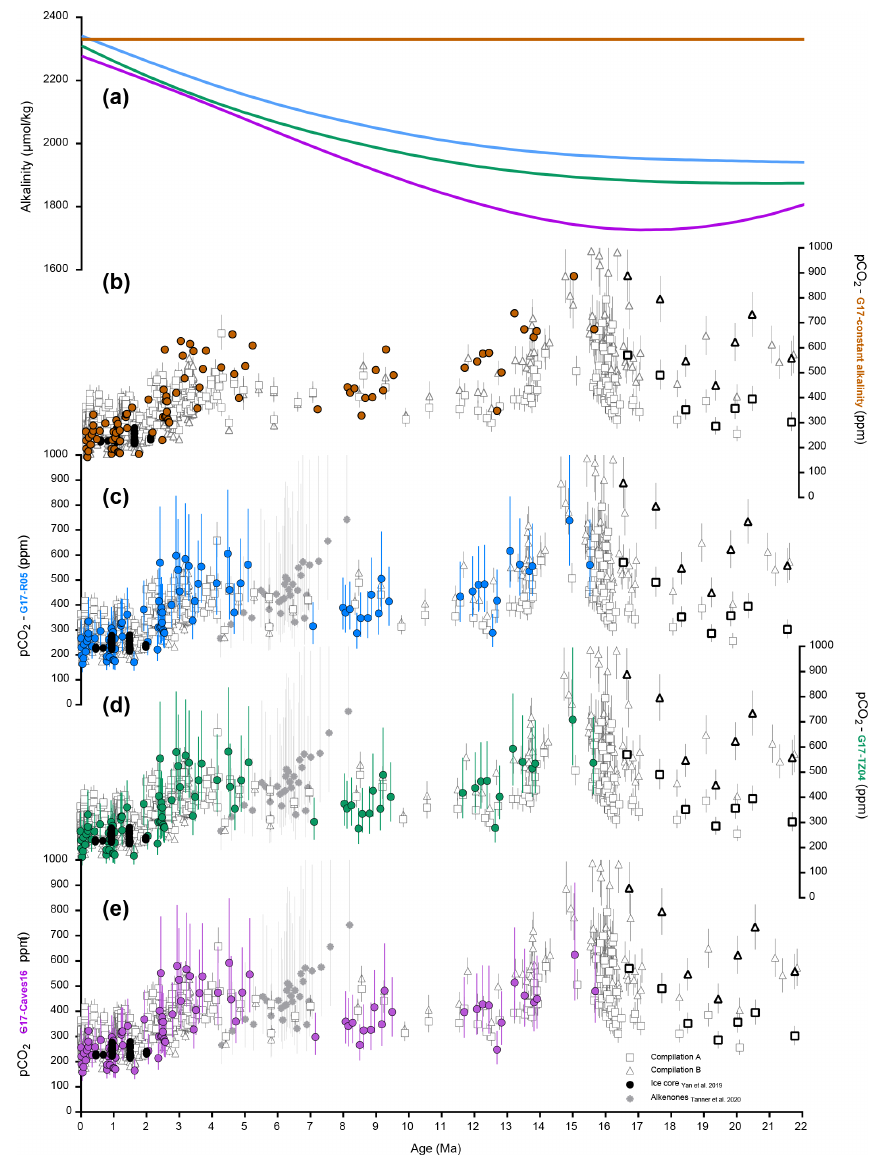
Figure 6. Different models for the evolution of a second carbonate (e.g., alkalinity) system parameter explored as part of this work. The propagated uncertainties were calculated using Eq. (S16) (see Supplement). (a) Different models for alkalinity used for the reconstruction of p CO 2 in this study (brown – constant alkalinity of 2330µmol/kg, blue – Ridgwell and Zeebe, 2005; green – Tyrrell and Zeebe, 2004; violet – Caves et al., 2016). Colored symbols are reconstructed p CO 2 based on our measured δ 11 B carbonate values, alkalinity scenario and δ 11 B seawater from Greenop et al. (2017); open squares (compilation A) are the p CO 2 compilation from Sosdian et al. (2018), open triangles (compilation B) are from the compilation by Rae et al. (2021), black symbols are from site 872. (b) Reconstructed p CO 2 using constant alkalinity of 2330µmol/kg and δ 11 B seawater from Greenop et al. (2017). (c) Reconstructed p CO 2 using the constant alkalinity scenario from Ridgwell and Zeebe (2005) and δ 11 B seawater from Greenop et al. (2017). (d) Reconstructed p CO 2 using constant alkalinity scenario from Tyrrell and Zeebe (2004) and δ 11 B seawater from Greenop et al. (2017). (e) Reconstructed p CO 2 using constant alkalinity scenario from Caves et al. (2016) and δ 11 B seawater from Greenop et al. (2017). In black are published estimates from ice core data (circles – Yan et al., 2019). Compilations of p CO 2 from Sosdian et al. (2018) (compilation A – open squares) and Rae et al. (2021) (compilation B – open triangles) are also shown for comparison. Data for compilation A are from Hönisch and Hemming (2009); Seki et al. (2010); Foster et al. (2012); Badger et al. (2013); Greenop et al. (2014); Martínez-Botí et al. (2015a); Chalk et al. (2017); Sosdian et al. (2018). Data for compilation B are from Foster (2008); Hönisch and Hemming (2009); Seki et al. (2010); Foster et al. (2012); Badger et al. (2013); Greenop et al. (2014); Martínez-Botí et al. (2015a); Chalk et al. (2017); Dyez et al. (2018); Sosdian et al. (2018); Greenop et al. (2019); de la Vega et al. (2020). Stars indicate p CO 2 values reconstructed from alkenones by Tanner et al. (2020) (simulation 6) at Site 1088 in the Southern Ocean.